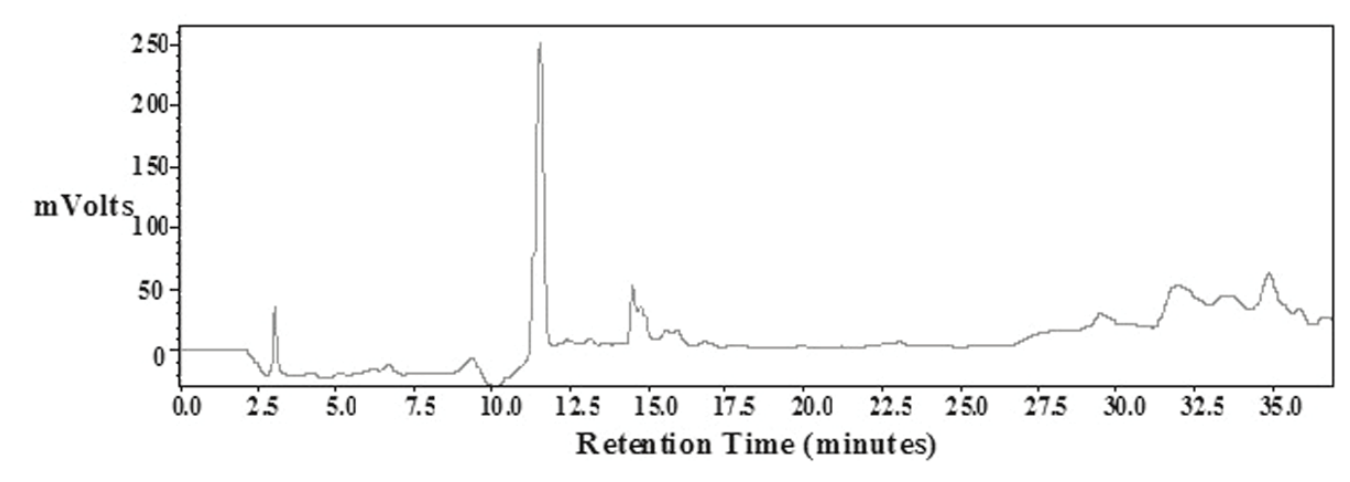
FIGuRE 1 - HPLC chromatogram of broccoli extract.